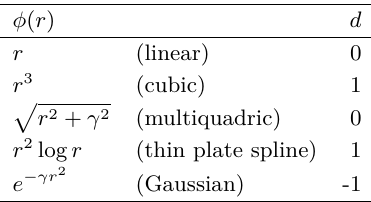
Table 1 RBF functions available in RBFOpt.